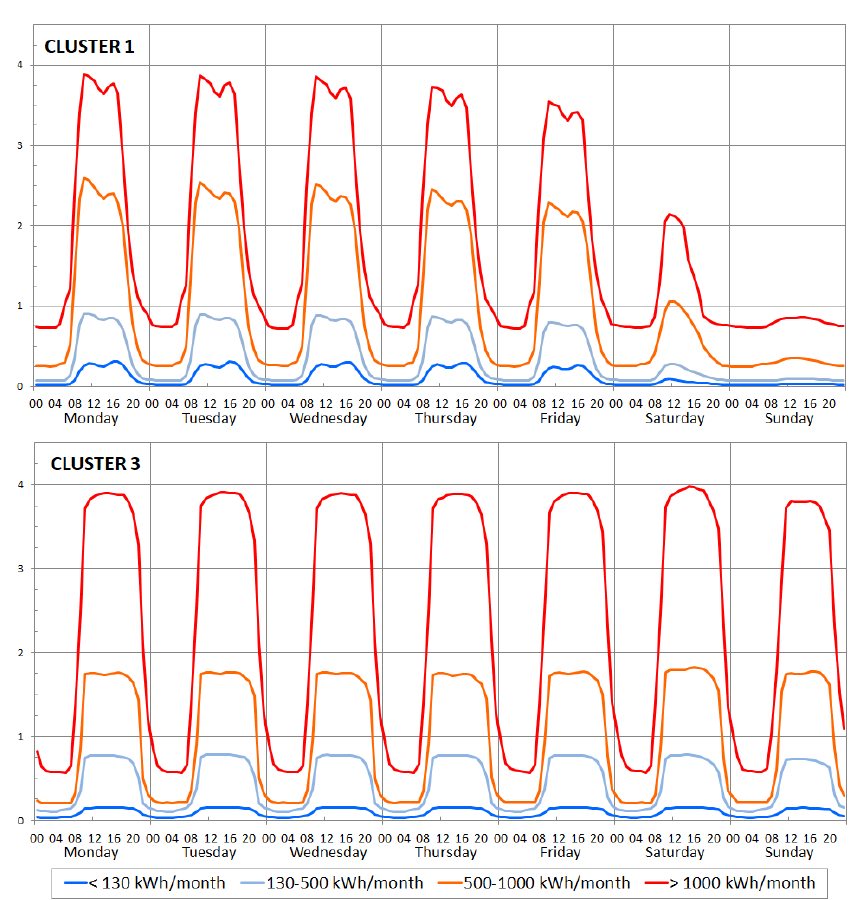
Figure 6. Average hourly load profiles are graphed from Monday to Sunday for type 1 and type 3 behaviours divided according to the energy consumed: less than 130, 130–500, 500–1000 and more than 1000